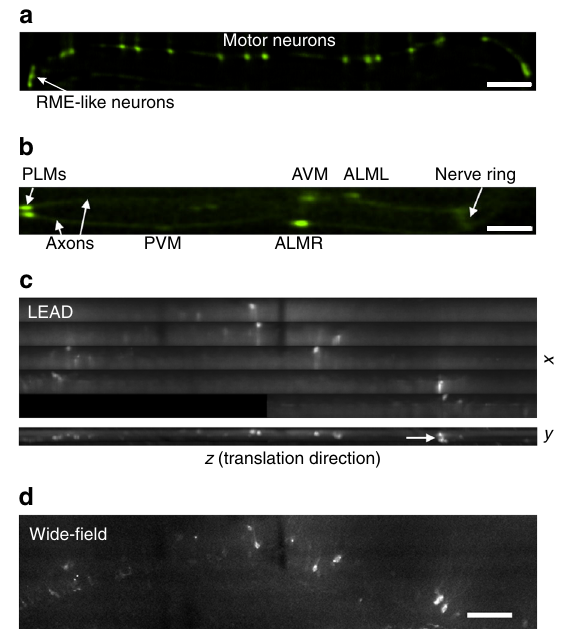
Fig. 4 Various samples imaged with the LEAD microscope. a Late L4 stage unc-25::GFP strain C. elegans , with GFP-labeled GABAergic neurons, including RME-like neurons in the head and motor neurons along the ventral cord. The thin ventral cord is at the detection limit of our system. Scale bar = 50 μ m. b Young L4 stage mec-4::GFP strain C. elegans , with GFP-labeled touch neurons. Planes 4 – 6 are summed, and we saturate the soma in post-processing so the axons are more visible. Scale bar = 50 μ m. c Maximum intensity projection images of Arc-dVenus transgenic mouse brain with neurons involved in fear conditioning labeled, stitching together 5 FOVs. A portion of the bottom-most FOV was not imaged. The y – z maximum intensity projection image demonstrates the axial sectioning capability of our system, with the arrow indicating two stacked neurons. d Inverted microscope image of the same volume as ( c ) with 4×, 0.13